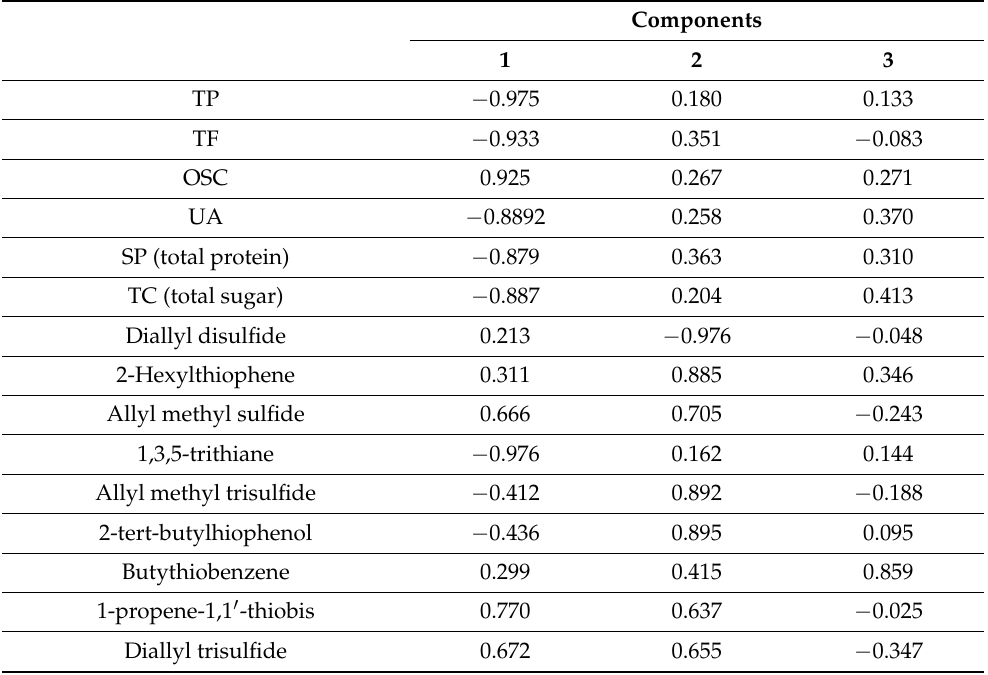
Table 4. Rotated component matrix by the principal component